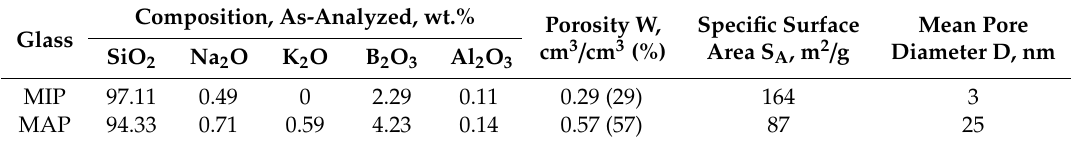
Table 1. Composition and the pore structure parameters of MIP and MAP